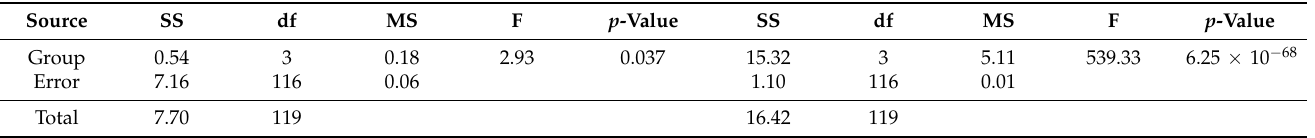
Table 7. ANOVA results of the left side columns are obtained from the PPG-based SVR-MF, PPG- based SVR-PS, PPG-based LSTM-MF, and PPG-based LSTM-PS models; ANOVA results of the right side columns are acquired from the PPG-based GBA-MF, PPG-based GBA-PS, PPG-based EGPR-MF, and PPG-based EGPR-PS, where SS is the sum of squares and df is the degrees of freedom. The total degree of freedom is 120 (=119-1) minus 1 from the total number of measurements (MAE).